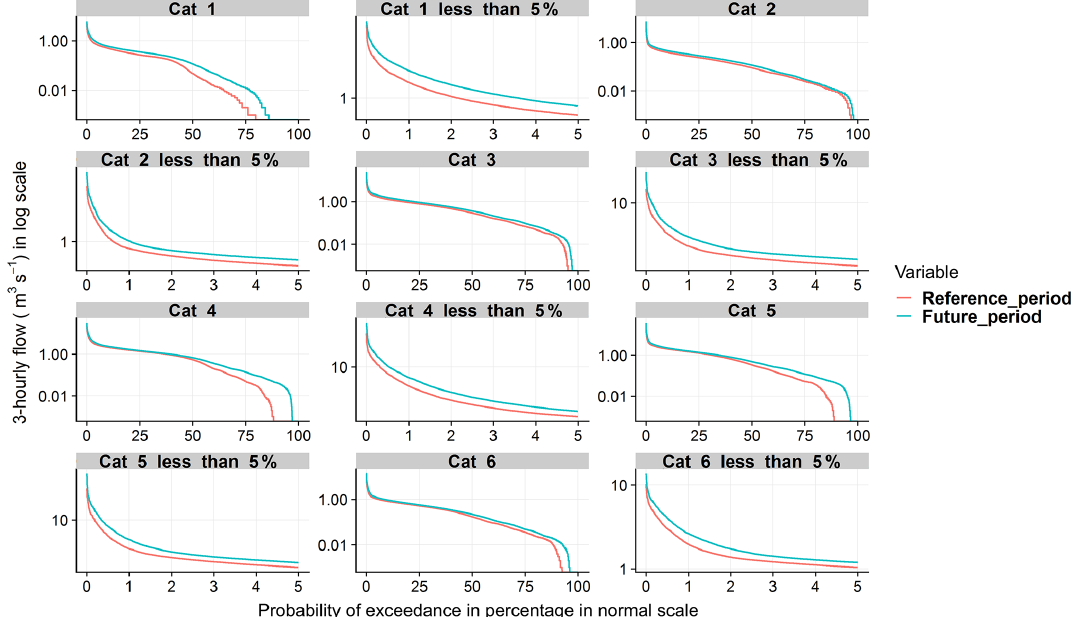
Figure 4. Flow duration curves (FDCs) of the 3-hourly flow for the six study catchments for the reference and the future periods with the probability of exceedance less than 5% and 100%.